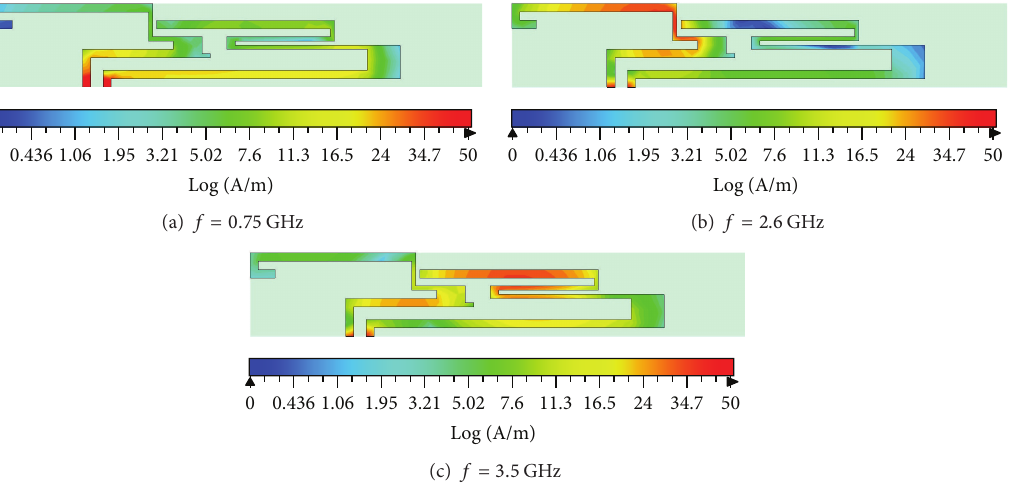
Figure 8: Surface current distributions on the radiating patch at (a) 0.75 GHz; (b) 2.6 GHz; and (c) 3.5 GHz.